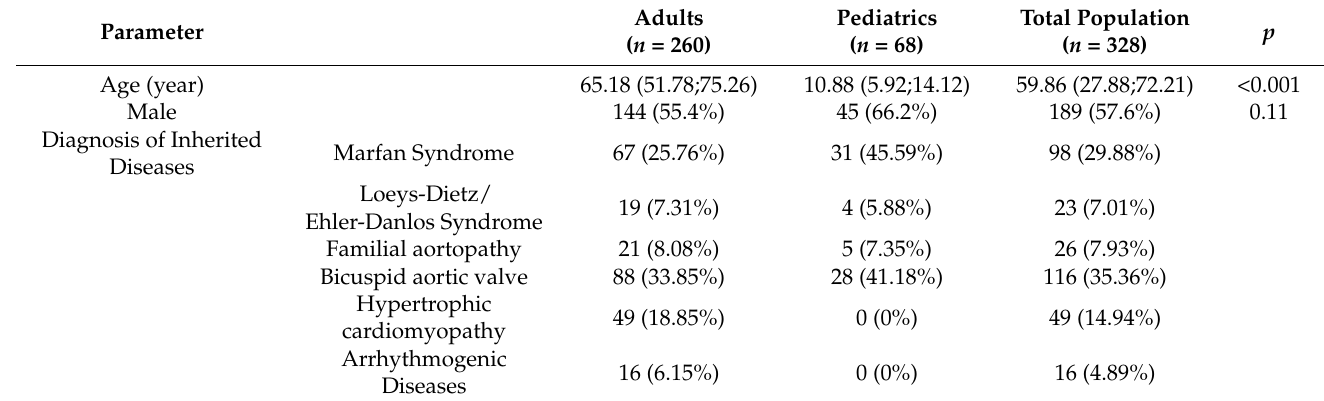
Table 1. Clinical characteristics for all subjects ( n =